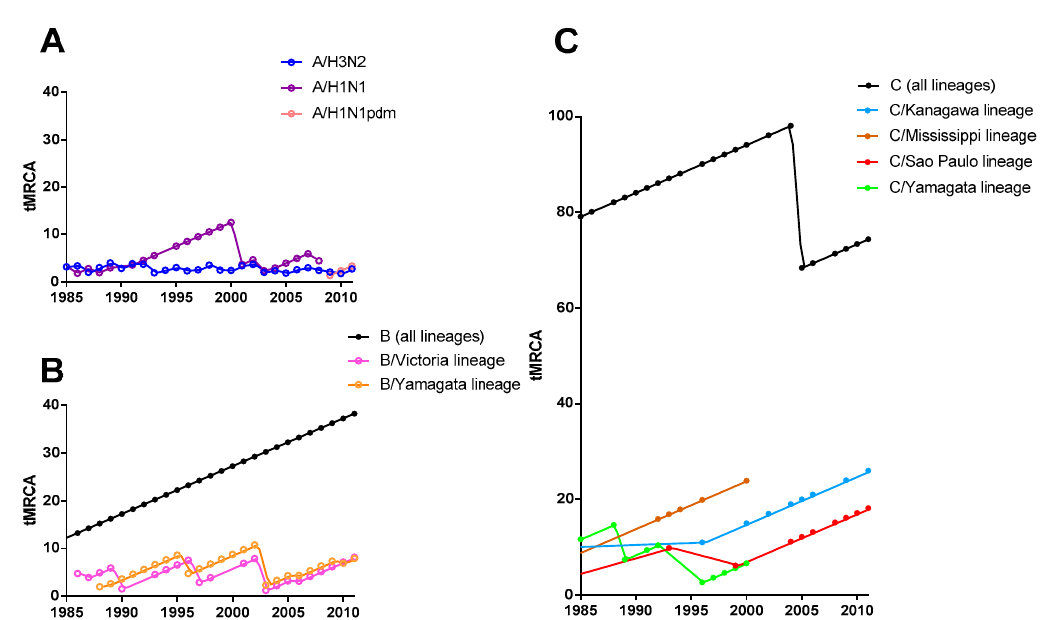
Figure 3. Time to the most recent common ancestor (tMRCA) of influenza A, B, and C viruses. Temporal trend of tMRCA among contemporaneous (same year) and posterior (at least three years) strains for the HA gene of influenza A and B viruses and the HE gene of the influenza C virus, in panel A , B , and C respectively. We did not plot the tMRCA of all influenza A viruses (A/H3N2, A/H1N1, and A/H1N1pdm together) because they are not monophyly. Additionally, tMRCA of influenza A/H1N1 (before 2009) and influenza A/H1N1pdm (in or after 2009) was calculated separately. Data are shown after 1985, since few sequences were available before that year. Since strains collected over four years are required to calculate tMRCA, sequence data up to 2014 yielded tMRCA up to 2011. No plots for the C/Aichi lineage and the C/Taylor lineage are presented because of the paucity of sequence data.